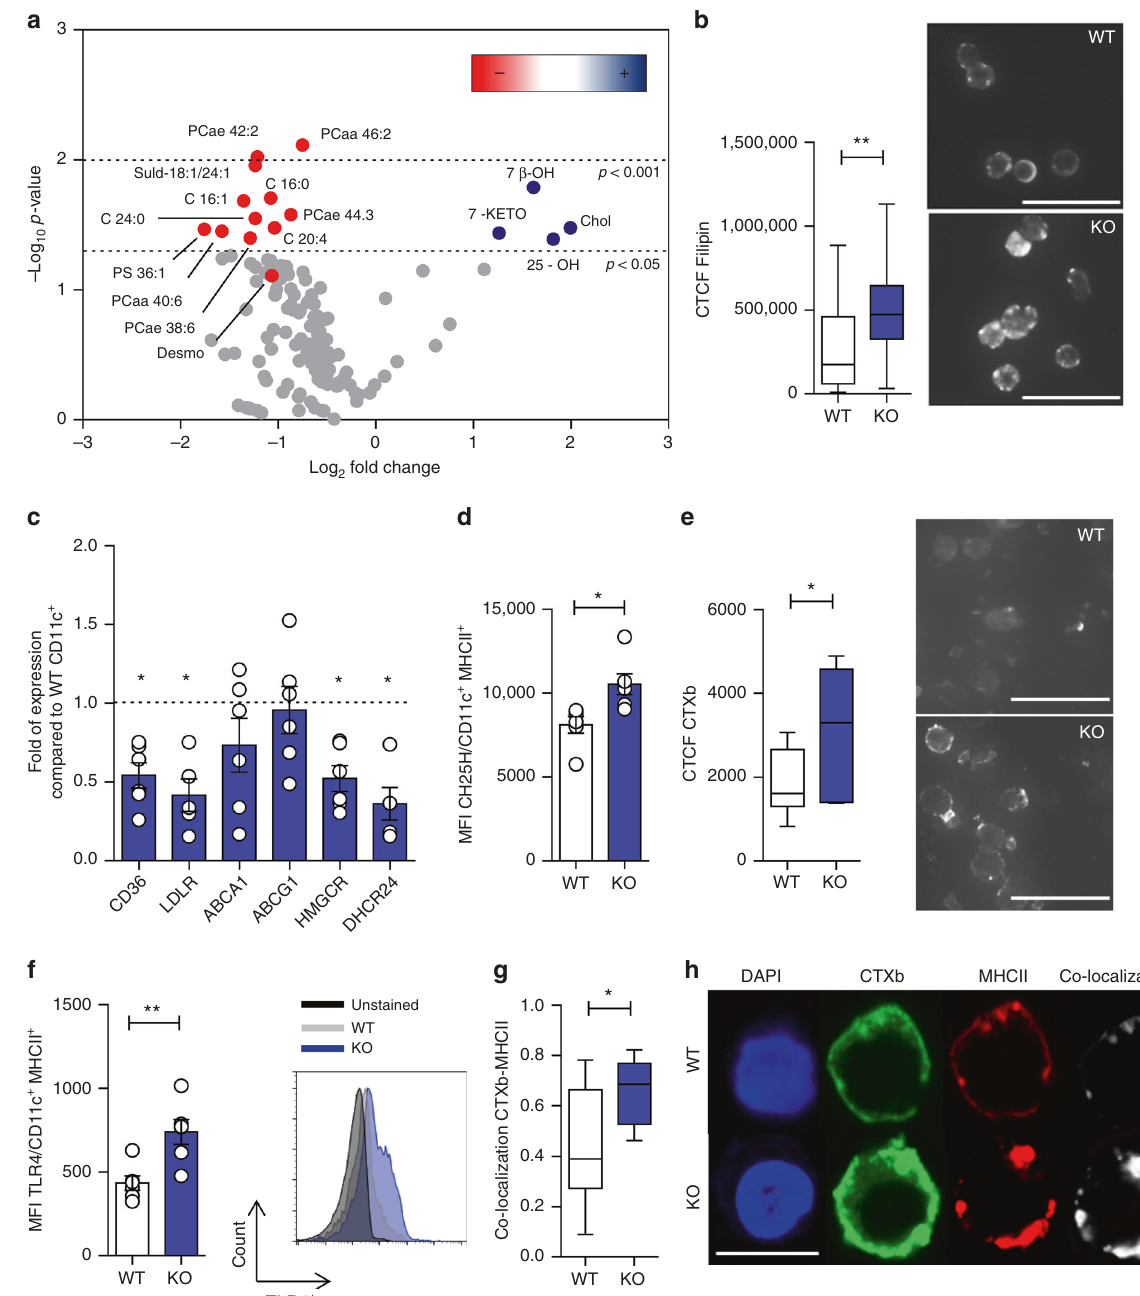
Fig. 5 ApoE de fi ciency affects lipid composition of DCs. a Volcano plot from extensive lipidomic analysis (fatty acids, phospholipids and oxysterols) in puri fi ed CD11c + DCs isolated from the spleen of WT or apoE KO mice. The volcano plot correlates fold-change expression (expressed as log2) and signi fi cance between two groups (WT vs. apoE KO), using a scatter plot view. The y-axis is the negative log10 of p -values (a higher value indicates greater signi fi cance as indicated by dashed lines) and the x -axis is the difference in levels of metabolites between two experimental groups. Metabolites which are signi fi cantly increased are shown by blue dots while red dots represent those decreased. b Total cell fl uorescence (CTCF) of free cholesterol ( fi lipin staining) in puri fi ed CD11c + DCs isolated from the spleen of WT or apoE KO mice, calculated with ImageJ software; representative pictures are shown (×20 magni fi cation, scale bar 25 µ m). c Expression of CD36, LDLR, ABCA1, ABCG1, HMGCR and DHCR24 mRNA by puri fi ed CD11c + DCs isolated from the spleen of WT or apoE KO mice. d Mean fl uorescence intensity (MFI) of CH25H in CD11c + MHCII + DCs of WT and apoE KO determined by fl ow cytometry. e Total cell fl uorescence (CTCF) of lipid rafts (CTXb) in puri fi ed CD11c + DCs isolated from the spleen of WT or apoE KO mice, calculated with ImageJ software; representative pictures are presented (×20 magni fi cation, scale bar 25 µ m). f Median fl uorescence intensity (MFI) of TLR4 expression in CD11c + MHCII + DCs of WT and apoE KO determined by fl ow cytometry; representative histograms are shown. g and h Pearson ’ s correlation coef fi cient between lipid rafts (CTXb) and MHCII calculated with ImageJ software ( g ) in puri fi ed CD11c + DCs isolated from the spleen of WT or apoE KO mice; representative pictures from confocal microscopy staining for CTXb (green), MHCII (red) and DAPI (nucleus, blu) are presented in h (×63 magni fi cation, scale bar 10 µ m). N = 4 ( a , b , e ) and N = 6 ( c , d , f – h ) per group. Statistical analysis was performed with unpaired T -test. Data are reported as mean ± SEM; box and whiskers shown min to max values; * p < 0.05, ** p <